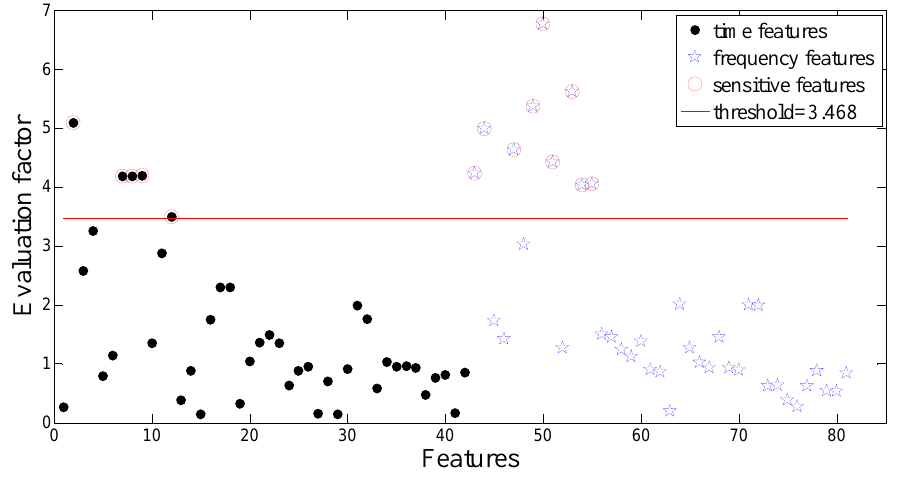
Figure 8. The evaluate factor of all the extracted features in the bevel gearbox